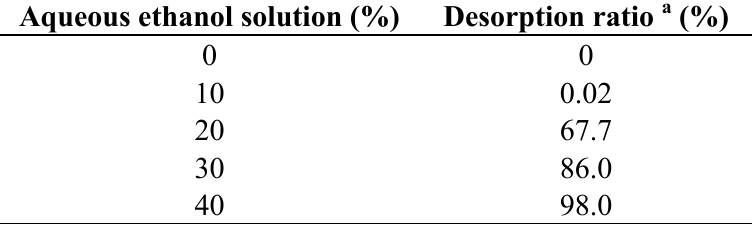
Table 3. Effect of the mobile phase on the mogroside V desorption